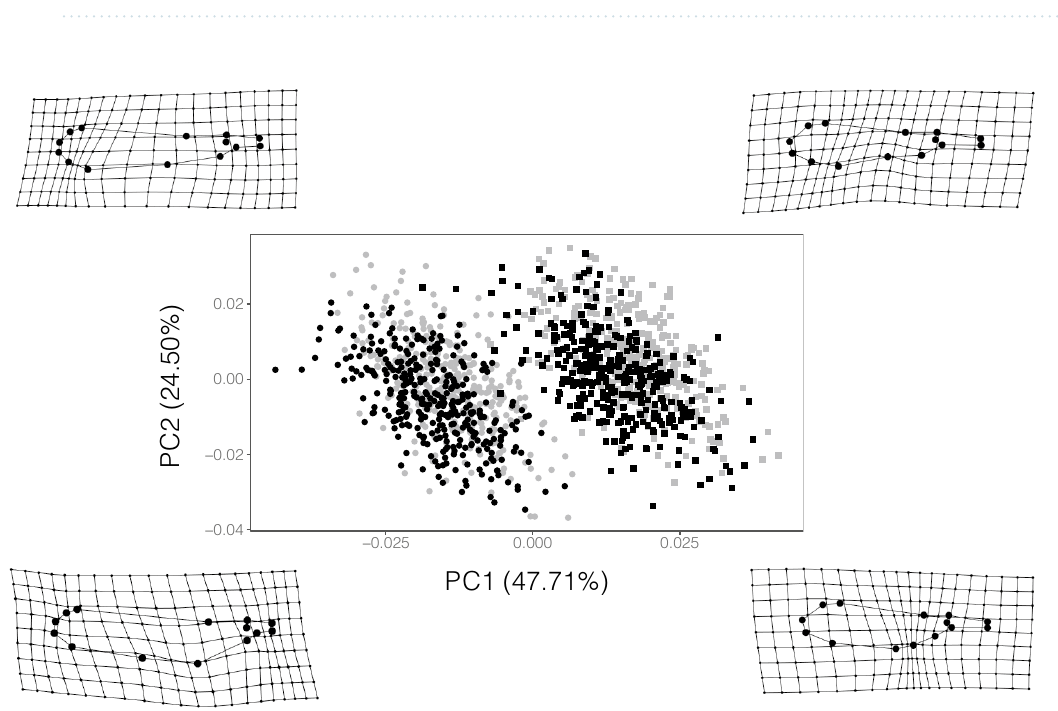
Table 2. Results of the General Linear Models inspecting the effects of latitude and sex on the variation of fore- and hindwing ratio in Lestes sponsa .